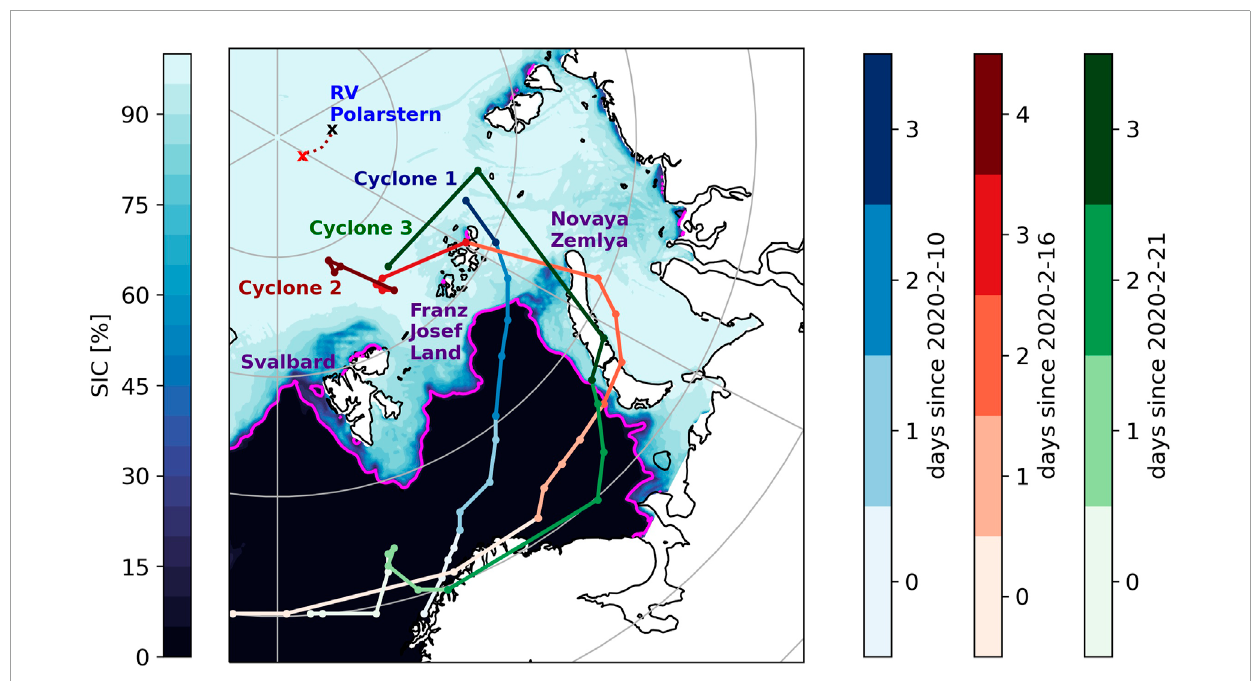
FIGURE 1 Track of cyclones 1, 2, and 3 (based on 6-hourly SLP minima in the study domain), indicated as blue, orange, and green lines, where the line color changes from bright to dark from the start to the end of the respective track. The position of the RV Polarstern at the start of the first (end of the third) cyclone event is marked as black (red) cross. Daily mean SIC and the 15% SIC contour (pink line) are shown for the day before the start of the first of the three cyclone passages (9 February 2020). SIC and cyclone tracks are based on the HIRHAM–NAOSIM